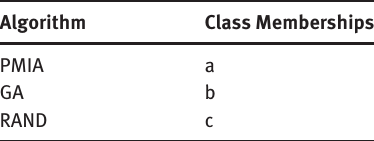
Table 2. Length 13 2 PSK: Tukey HSD Class Memberships.